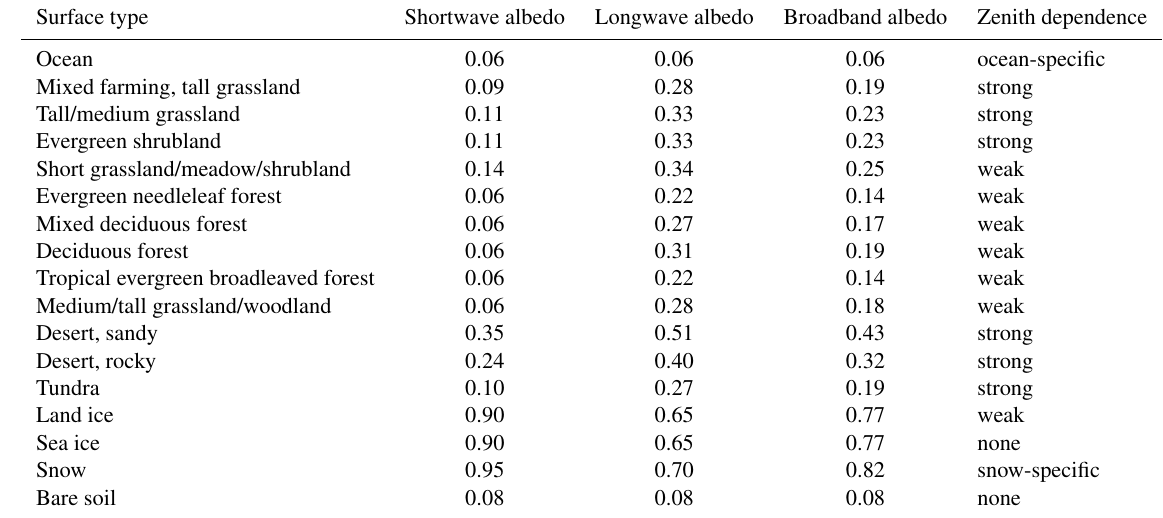
Table 7. Albedos for a solar angle of 80 ◦ for different surface types. Surface